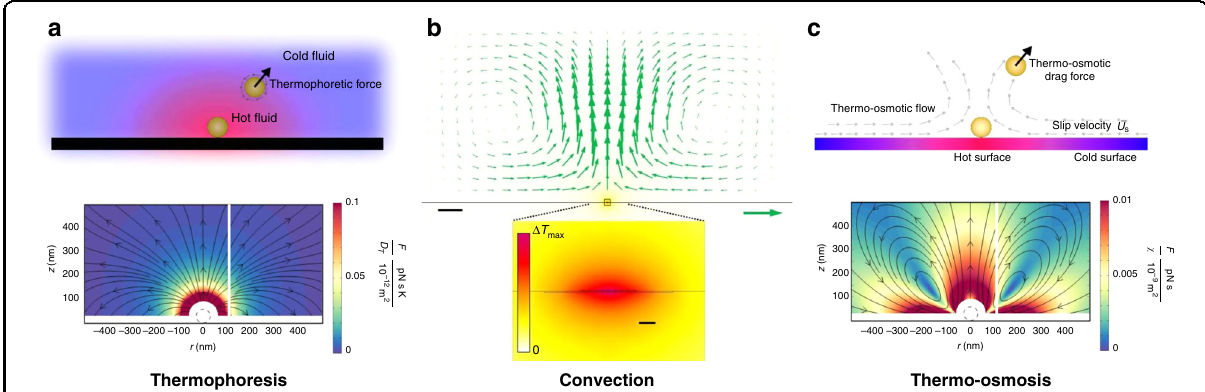
Fig. 3 Photothermal and plasma thermal effects in plasmonic trapping. Thermal effects are a natural component in opto-plasmonic systems. The three main types include thermophoresis ( a ), convection ( b ) and thermo-osmosis ( c ). a , c Reproduced with permission from ref. 80 , Copyright 2017, American Chemical Society. b Adapted with permission from ref. 87 , Copyright 2014, Macmillan